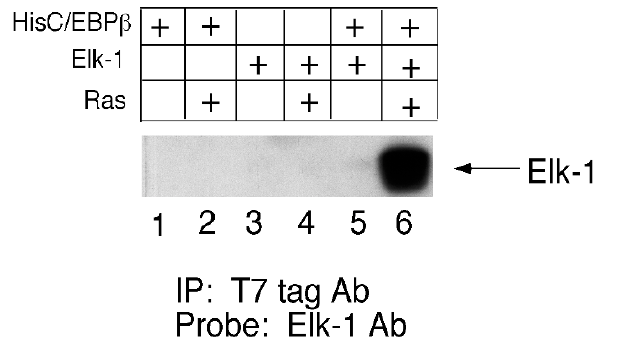
Figure 3 Elk-1 binds to GST-p35-C/EBP β in vitro . Radiolabeled Elk-1 Figure 4